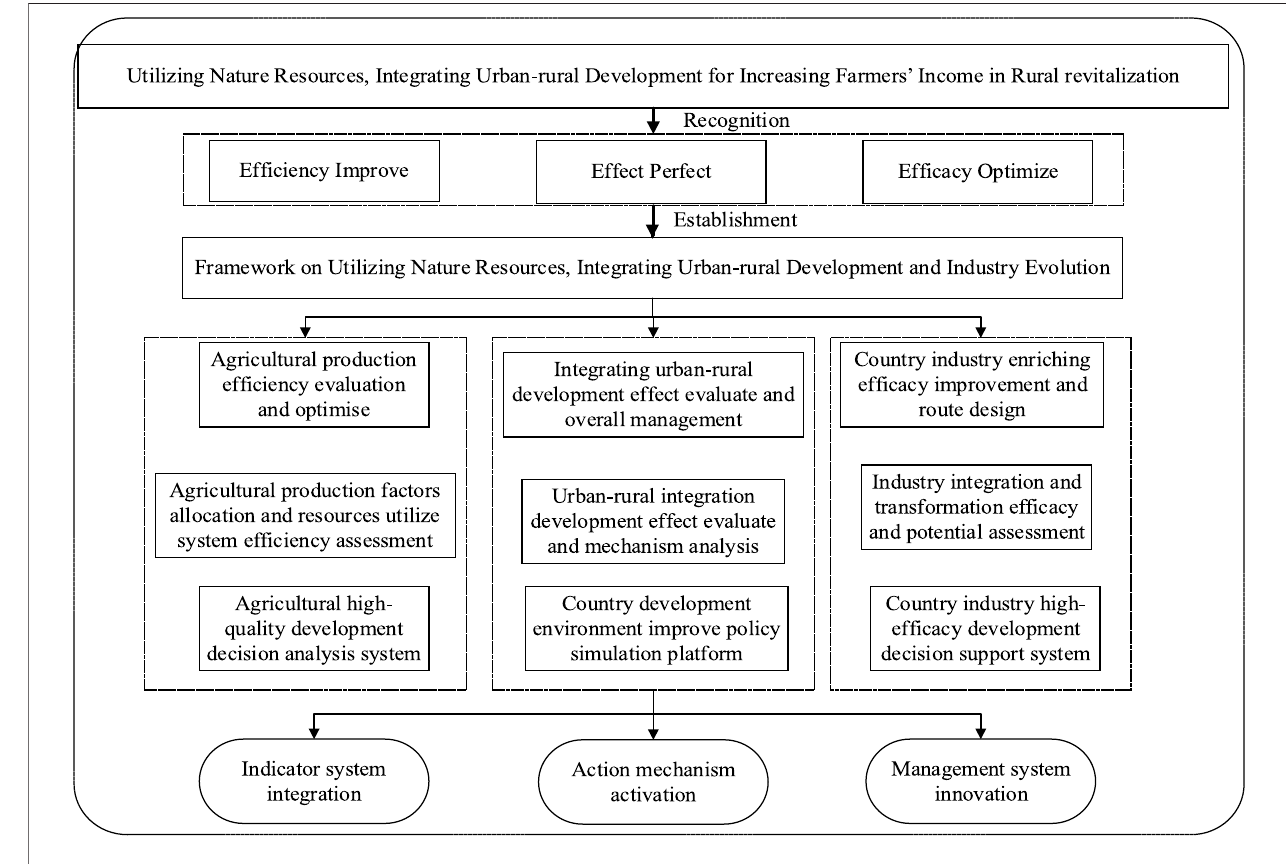
FIGURE 1 | Framework on Utilizing Nature Resources, Integrating Urban-rural Development for Increasing Farmers ’ Income in Rural revitalization.